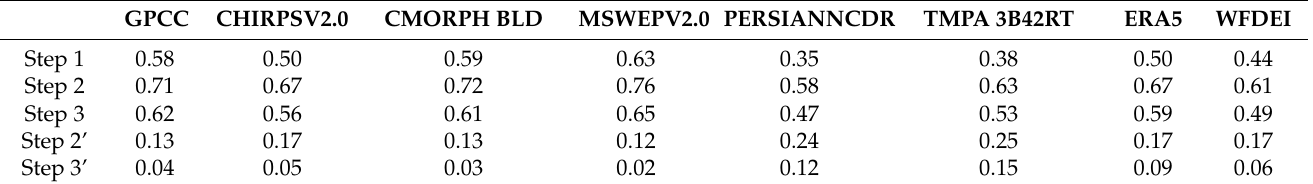
Table 2. Median NSE scores of the eight PPs for hydrological modeling based on three steps.